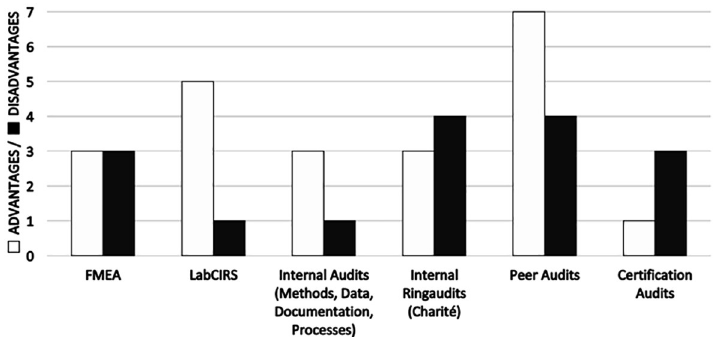
Fig 2. Graphical representation of the number of advantages and disadvantages of audits and assessments as perceived by members of the department.